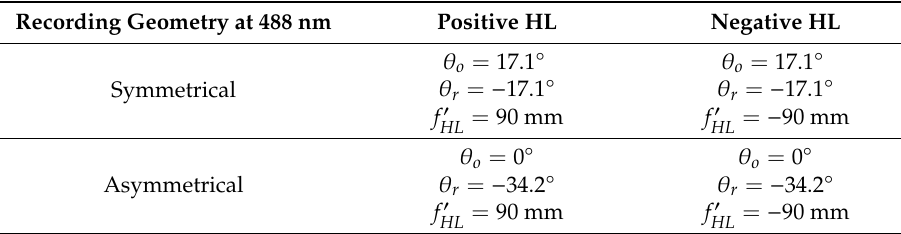
Table 1. Parameters for the recording of the